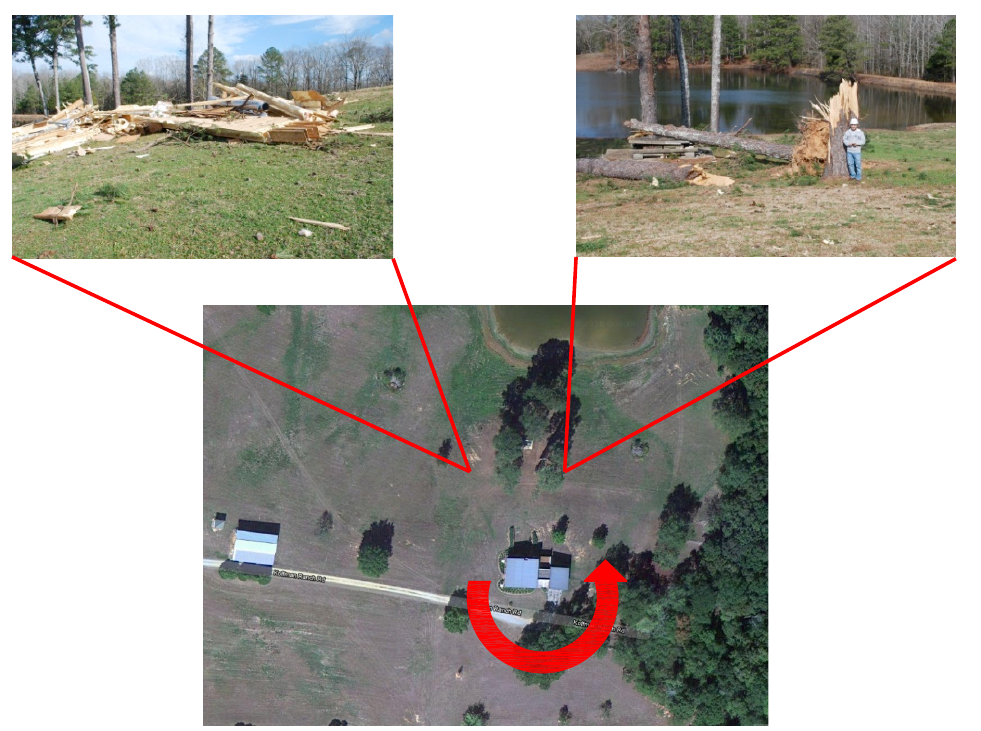
Figure 4. Site plan and damage overview.